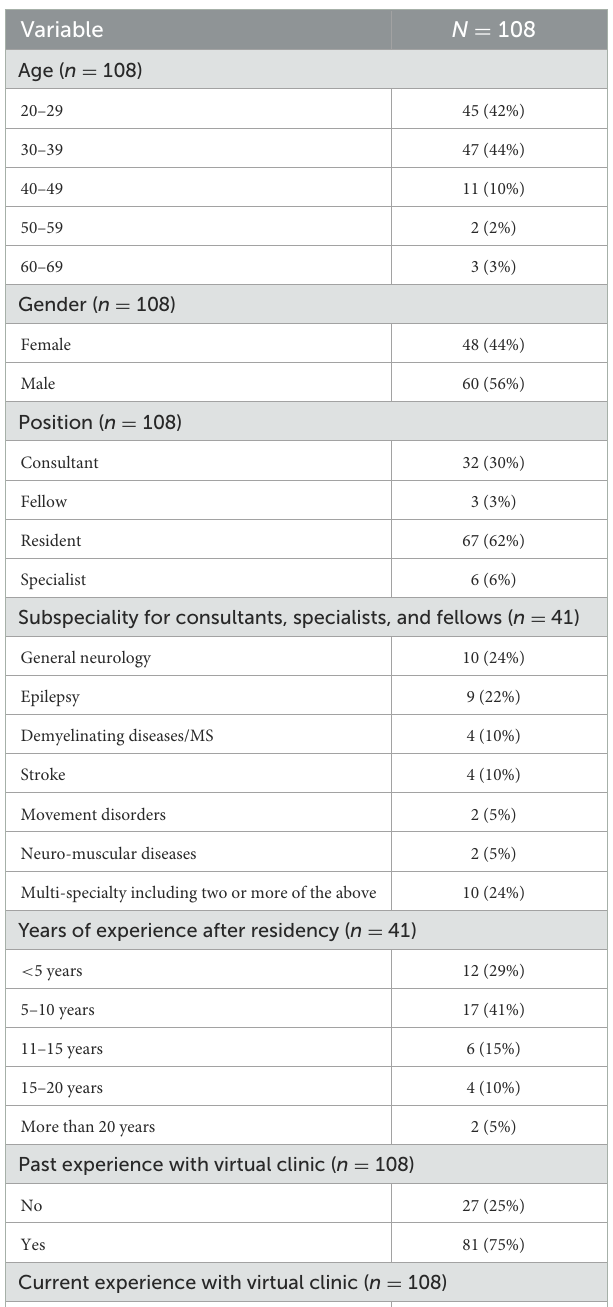
TABLE 1 Basic characteristics of